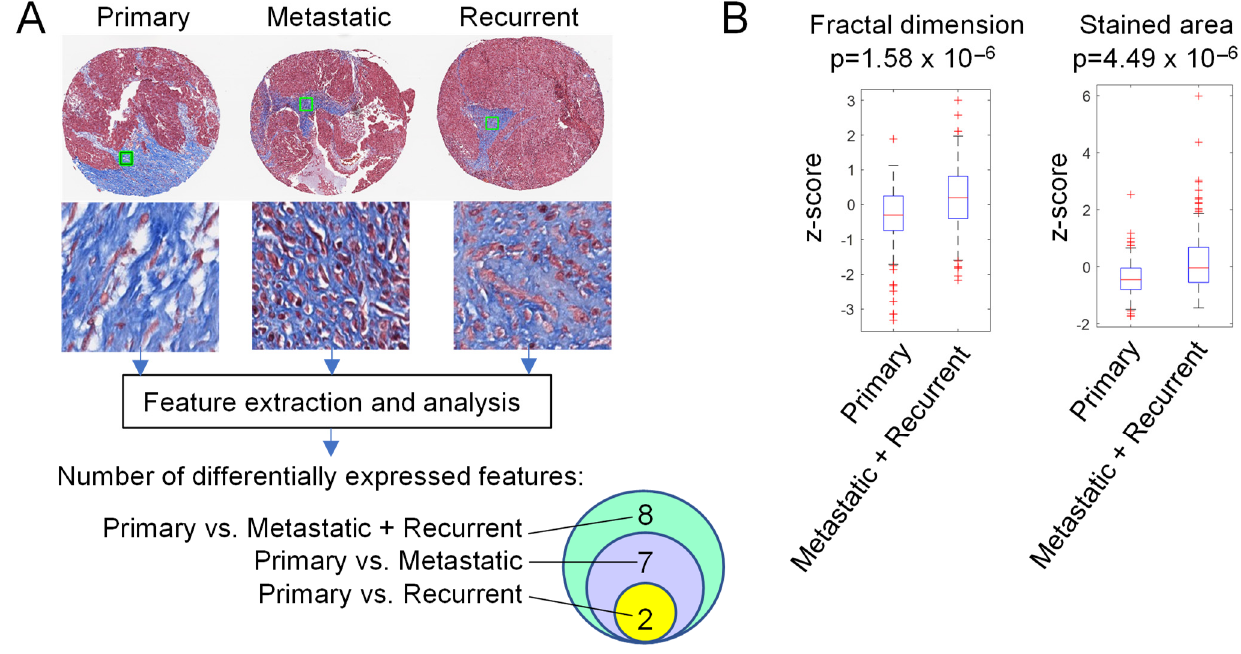
Figure 4. Metastatic and recurrent tumors have a different ECM texture and pattern than primary HGSOC. ( A ) Workflow diagram of tile selection for feature extraction and analysis. Shown is a randomly selected (not necessarily representative) set of TMA cores from primary, metastatic, and recurrent tumors and the corresponding manually selected stroma tiles (green squares in cores shown at higher magnification below). The number of differentially expressed features identified through statistical analysis is shown in the Venn diagram. ( B ) Examples of expression boxplots for two image features differentially expressed between Primary vs. Metastasis + Recurrence groups of image tiles.